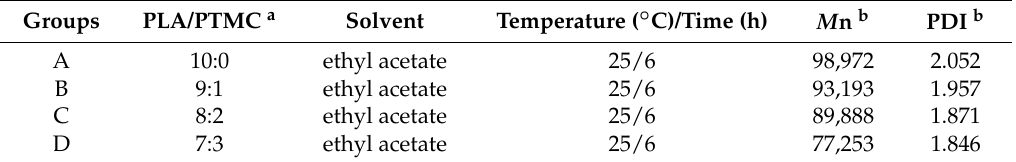
Table 1. Molecular characteristics of poly(lactic acid) (PLA) and PLA/PTMC (poly(lactic Molecular characteristics of poly(lactic acid) (PLA) and PLA/PTMC (poly(lactic acid)/poly(trimethylene carbonate)) blends with different ratios. acid)/poly(trimethylene carbonate)) blends with different ratios.